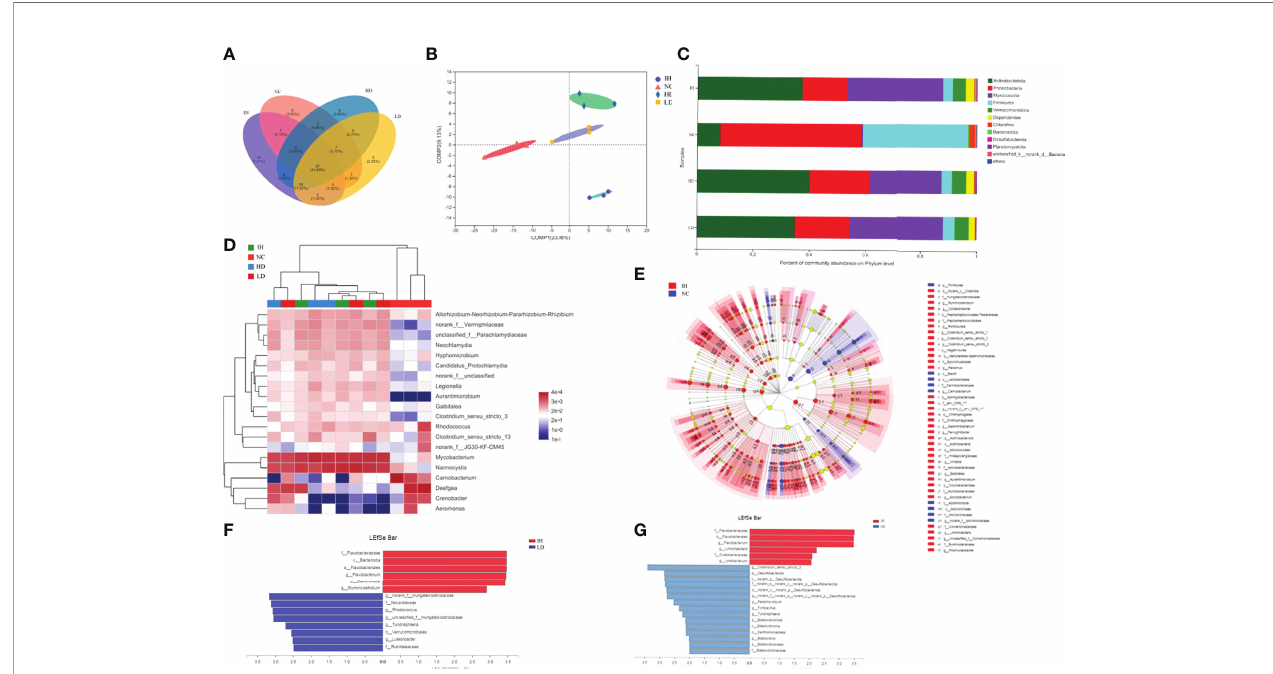
FIGURE 5 | Effects of supplementary 1% and 2% of CLNT on intestinal microbiota in IHNV-infected rainbow trout. (A) OTU-Venn analysis of intestinal microbiota; (B) PLS-DA analysis of intestinal microbiota; (C) relative abundances of major phyla above 0.10% in at least one group; (D) community heat map analysis of top 20 genera in each group; (E) LDA Effect Size (LEfSe) analysis of microbes between NC and IH groups, LDA>4, P <0.05; (F) LEfSe analysis of microbes between LD and IH groups, LDA>2.5, P <0.05; (G) LEfSe analysis of microbes between HD and IH groups, LDA>2, P <0.05.